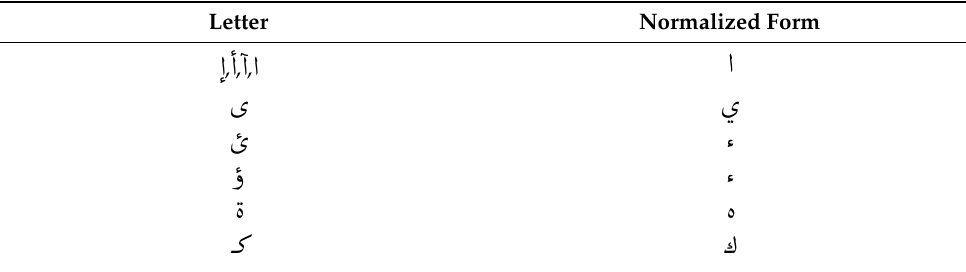
Table 4. Examples of some letters in normalization form.